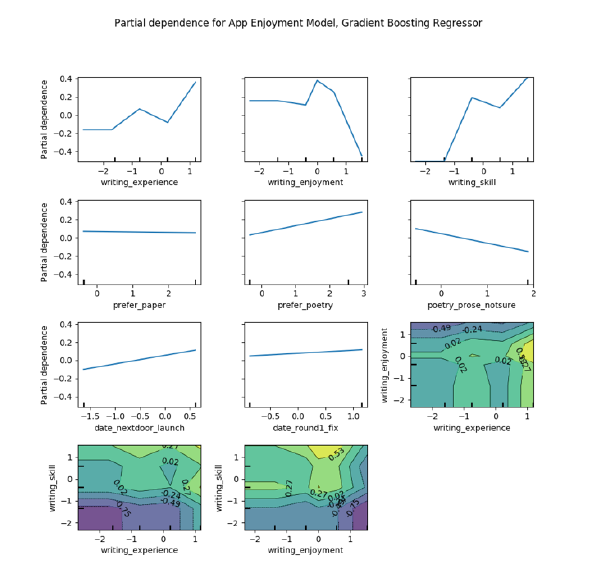
Figure 29. Partial dependence for Question 7 model